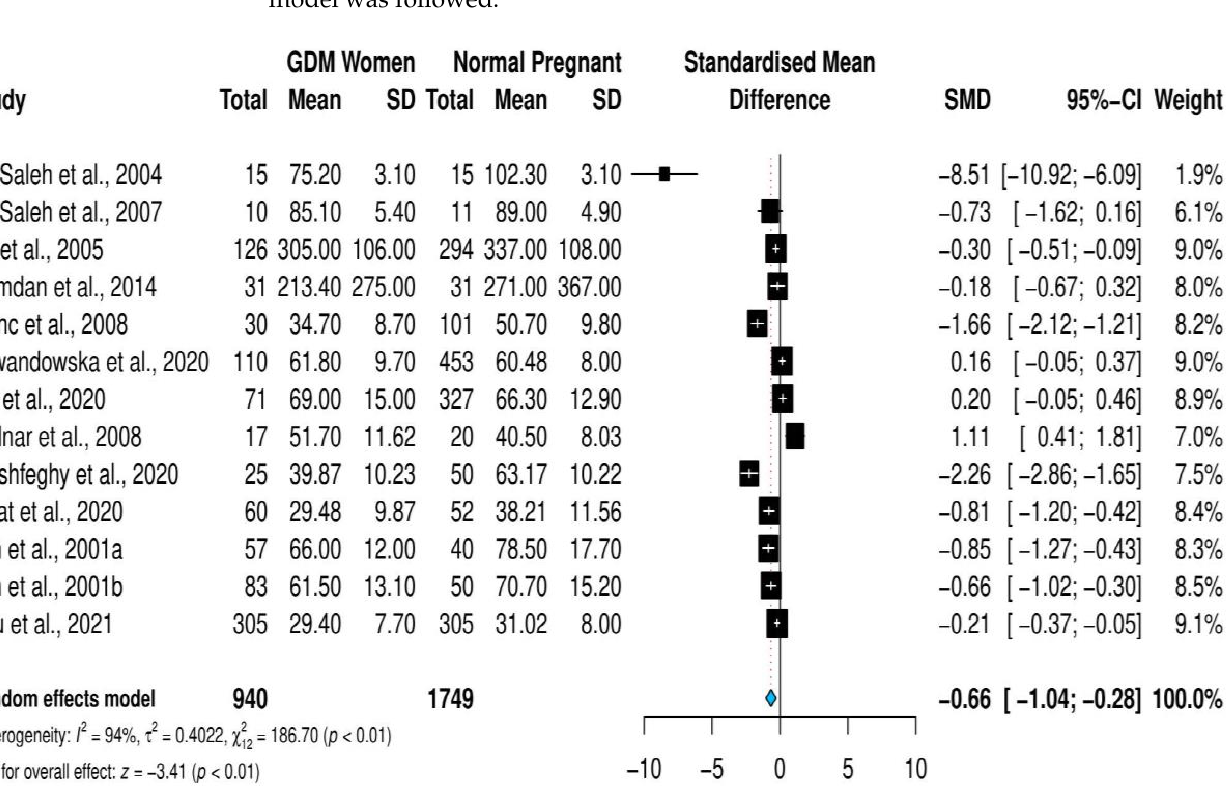
mellitus Figure 2. Forest plot of the association between selenium SMD levels and gestational diabetes melli- tus[20 – 26,29,31,38,39,43,44].